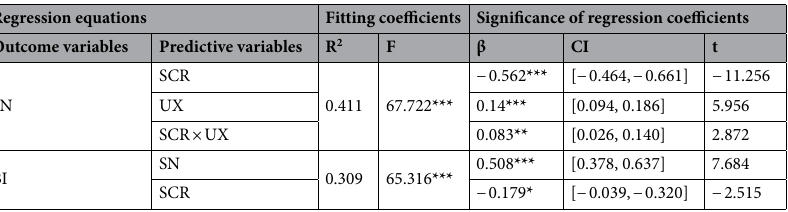
Table 5. Mediated role with